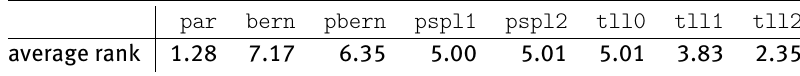
Table 2: The relative rank of estimators averaged over all